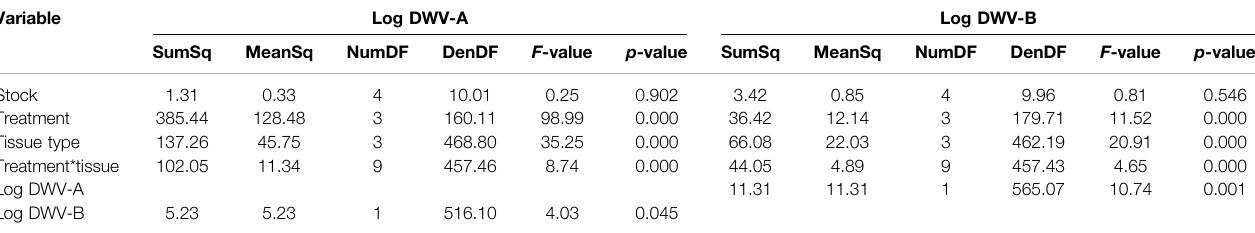
TABLE 1 | DWV dissemination ANOVAs. ANOVA summary of the generalized linear mixed-model fi xed effects for the log-transformed DWV-A and DWV-B RNA copy levels disseminated throughout the newly emerged adult tissues (N = 180 bees total and N = 720 RNA extractions in total). Supplementary Table S1 for model parameter